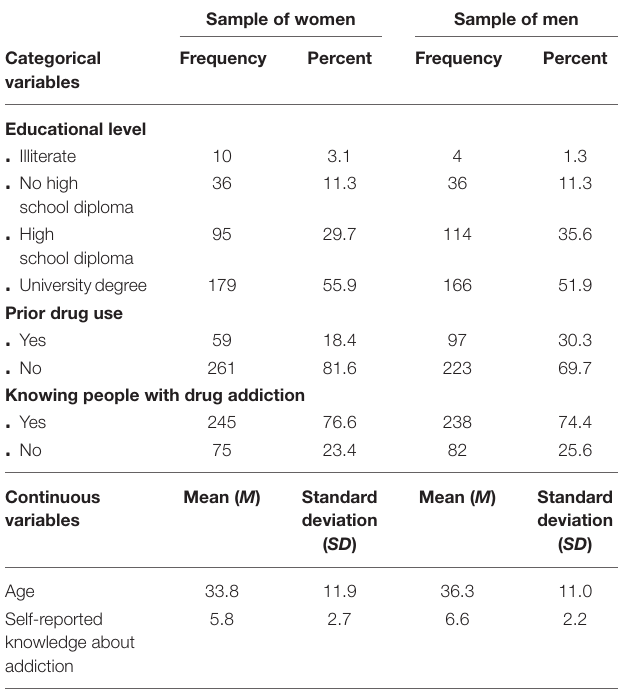
TABLE 2 | Descriptive statistics of the respondents’ characteristics in the sample of women ( N = 320) and men ( N = 320), with EM-imputation. Sample of women Sample of